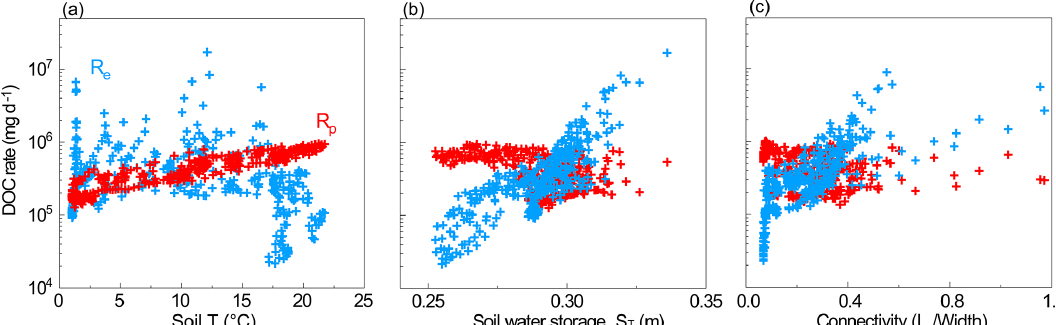
Figure 8. The catchment-scale DOC production rate R p and export rate R e as a function of (a) soil T , (b) soil water storage S T , and (c) hydrological connectivity ( I cs / Width). Cross symbols are daily values in the base case. R p increased with soil T and decreased slightly with S T and connectivity. In contrast, R e increased with S T and connectivity but decreased with soil T . R e tended to decrease with soil T in the hot, dry summer due to low discharge during that